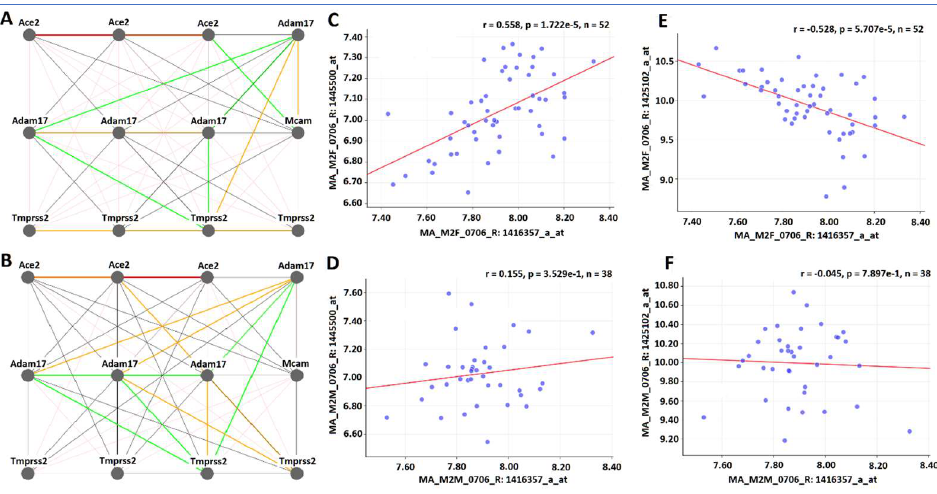
Figure 2. Gene expression network of Ace2 , Adam17 , Tmprss2 , and Cd146 in kidney among female and male mice. The 12 nodes in the graph show the selected traits. The node labels are drawn with 18.0 point font, and the edge labels are drawn with a 18.0 point font. In ( A , B ), the thick, wide, and solid red lines indicate the value of r is more than 0.75, representing the positive correlation between the genes on both ends of the connection. The thin, solid pent and green lines indicate the absolute value of r is between >0.35–<0.75, represent the positive and negative correlations. The dashed lines indicate the absolute value of r is <0.35, no correlations. ( A ) Pearson correlation coefficients among probes of four genes in the female mice. ( B ) Pearson correlation coefficients in the male mice. ( C ) Positive relationship between probes 1,445,500 of Adam17 and Cd146 in the female mice. ( D ) No correlation between probe 1,445,500 from Adam 17 and Cd146 in the male mice. ( E ) Negative correlation between probe 1,425,102 in Ace2 and Cd146 in the female mice. ( F ) No correlation between probe 1,425,102 in Ace2 and Cd146 in the male mice.